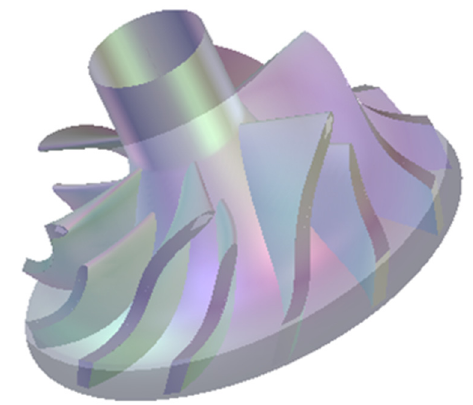
Figure 1. Impeller geometry model.